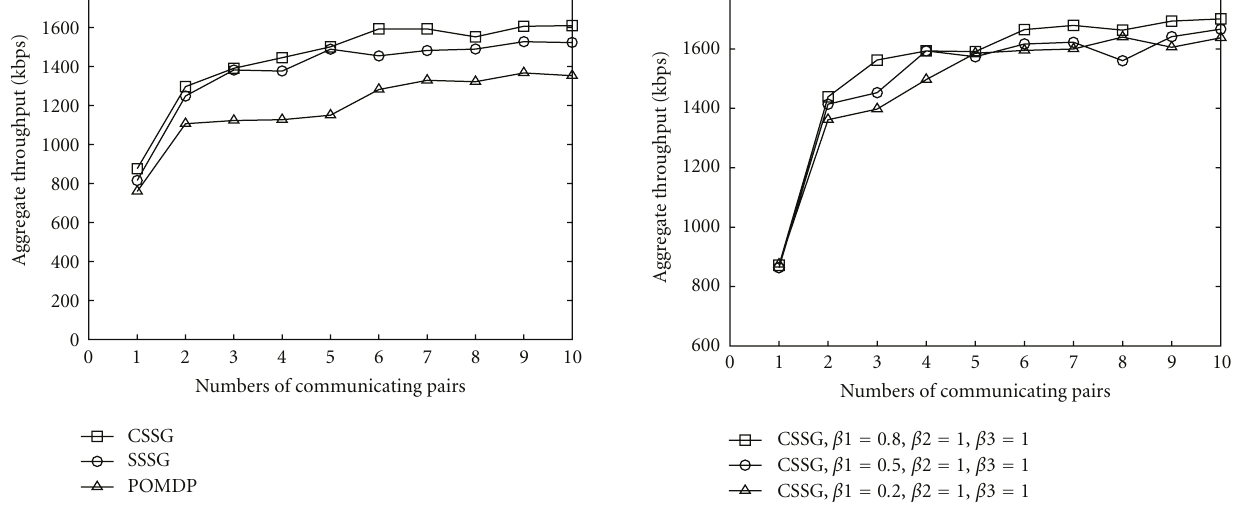
Figure 10: Aggregate throughput. Channel 1: β = 0.8. Channel 2: β = 0.8. Channel 3: β = 1.0.